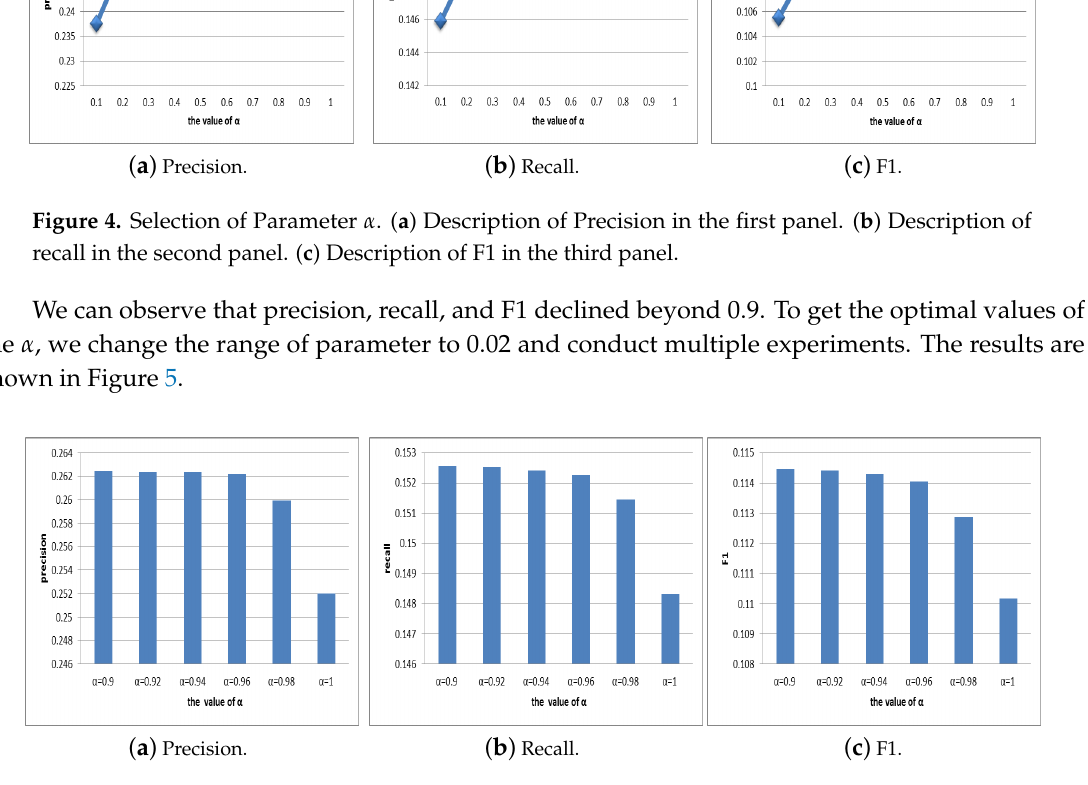
Figure 5. Selection of Parameter α . ( a ) Description of precision in the first panel. ( b ) Description of recall in the second panel. ( c ) Description of F1 in the third